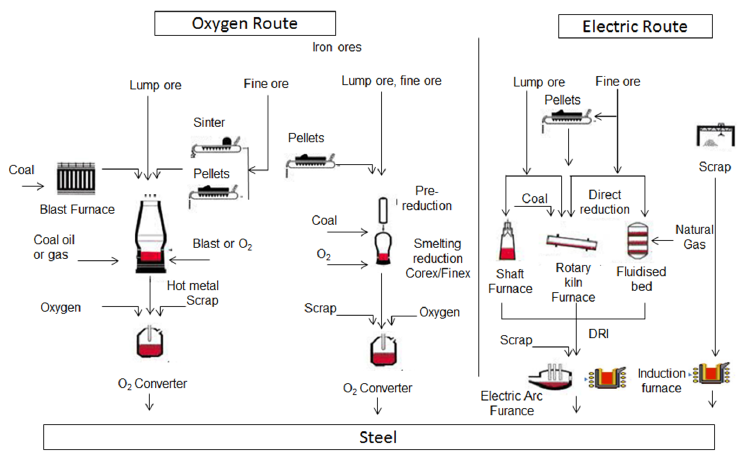
Figure 3. Indian steelmaking routes process map. Table 1. Capacity of iron and steel industry in India as of 2018–2019; Source: The Energy and Resources Institute based on data from Joint Plant Committee.